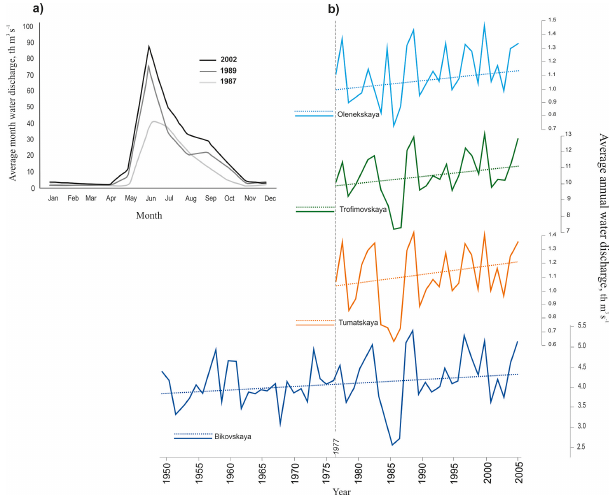
Figure 2. (a) Typical hydrograph for the Lena River delta (on the main channel section): average monthly water discharges for years with minimal (1987), maximal (1989), and average (2002) runoff; (b) average annual water discharge from 1950 to 2005 on branches of the Lena River delta according to data from Roshydromet (Hy- drological yearbooks, 2002–2005).